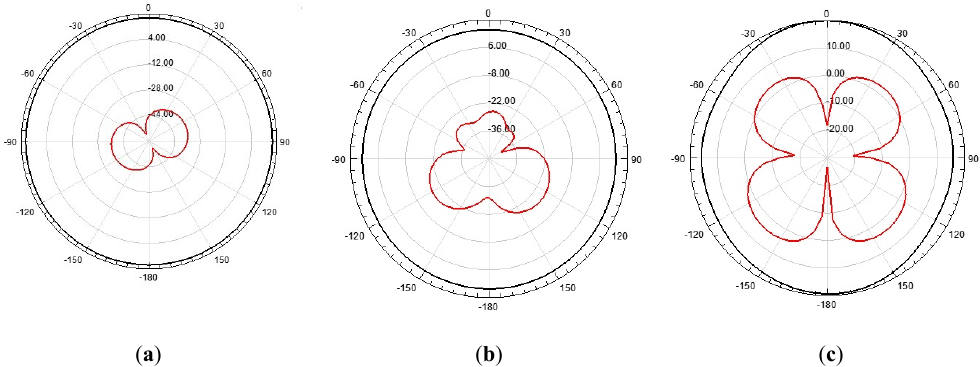
Figure 11. Bio ‐ inspired PMA H ‐ plane co ‐ polarization (black) and cross ‐ polarization (red) radiation patterns, respectively: ( a ) 350 MHz; ( b ) 900 MHz; (c) 1500 MHz.